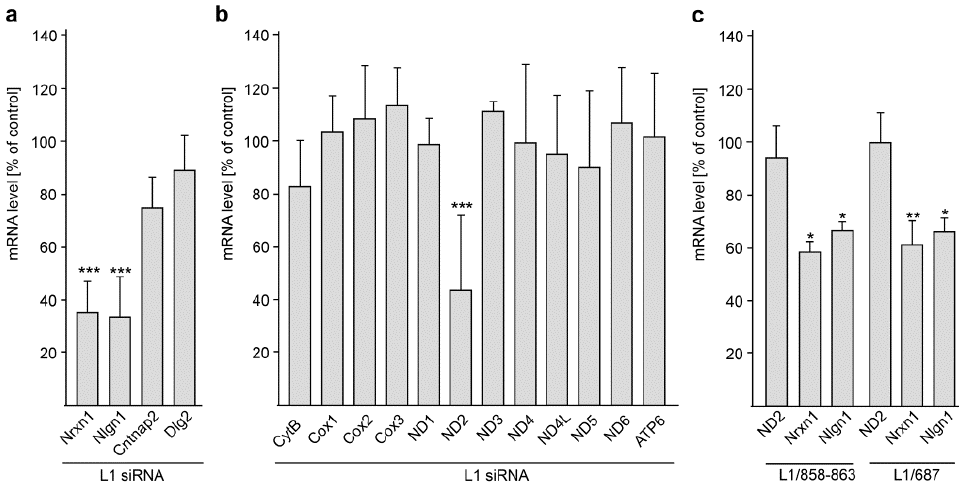
Figure 9. The L1/TOP1 interaction regulates the expression of the long autism genes Nrxn1 and Nlgn1 and the expression of the mitochondrial gene ND2. Cortical neurons were mock-transfected or transfected with L1 siRNA and subjected to RNA isolation and RT-qPCR 48 h after seeding. The mRNA levels of long autism ( a ) or mitochondrial ( b ) genes were normalized to the actin mRNA levels. ( c ) Cerebellar neurons from L1/858-863 mutant, L1/687 mutant and their wild-type littermates were maintained in culture for 48 h and subjected to RNA isolation and RT-qPCR. The ND2, Nrx1 and Nrx1 mRNA levels were normalized to the actin mRNA levels. Mean values + SD from five independent experiments with triplicates ( n = 5 mice) ( a , b ) or from six cultures per genotype ( n = 6 mice) ( c ) are shown for normalized mRNA levels in neurons after transfection with L1 siRNA relative to the levels in mock-transfected neurons ( a , b ) or in mutant neurons relative to wild-type neurons ( c ) (* p < 0.05, ** p < 0.01, *** p < 0.005; one-way ANOVA with Tukey’s ( a , b ) or Bonferroni’s